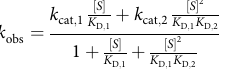
Fig. 10b. Rate constants derived from the experiments and used in the simulations are: (i) the equilibrium constant ( K close/open ) of opening/closing from the NMR data, (ii) the dissociation constants ( K D ) and k cat values from the steady-state kinetics data of PTP measured at 35 °C, and (iii) the k close that was estimated to be 5.8s − 1 (i.e., roughly twofold higher than the value obtained from stopped- fl ow experiments at 25°C). The purpose of these simulations was to qualitatively explain the k obs for the DiFMUP activity data with FL-WT and FL-E76D. Using the known kinetic parameters (see above), we are able to recapitulate the activity data